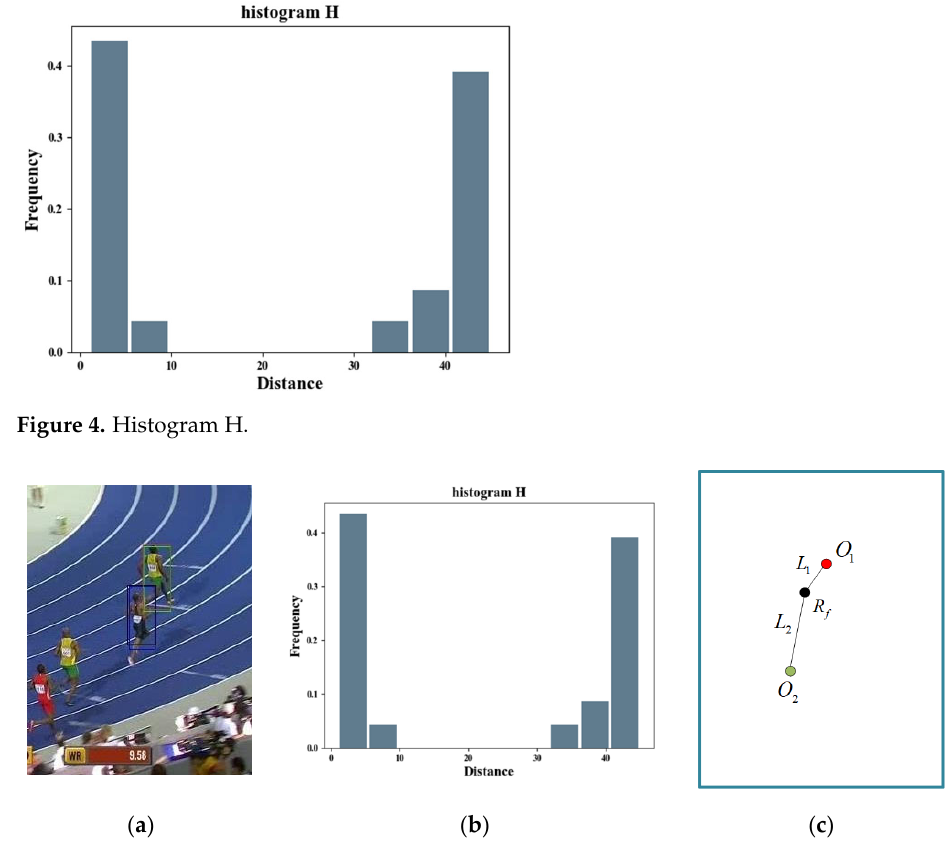
Figure 5. Transfer arbiter. ( a ) shows the distribution of candidate targets for the current scene; ( b ) is the result of histogram statistics of the distance between candidate frames; ( c ) shows the tracking results and the center distance of similar objects schematically.